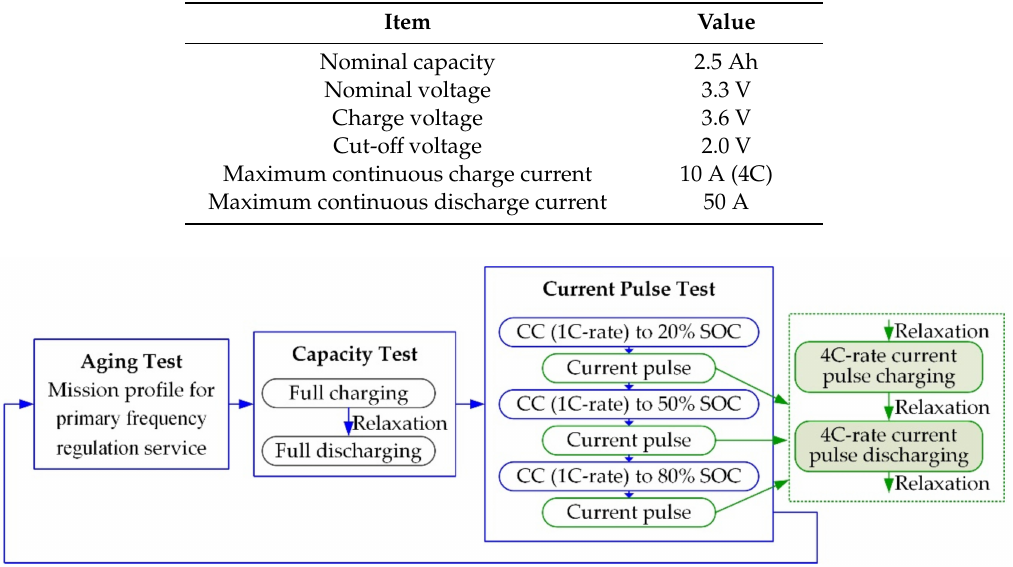
Figure 1. The flowchart of the test